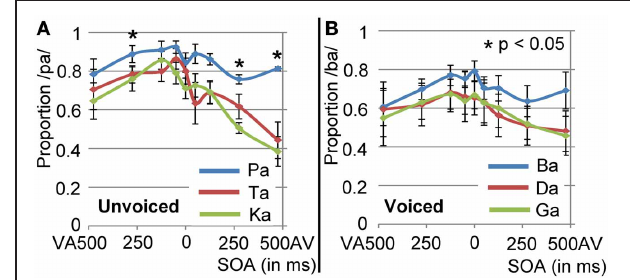
FIGURE 5 | Results for visual /pa/ presentation for unvoiced stimuli (A) and voiced (B) stimuli. Only response proportions are shown for the response options that were given above chance level. These response options were /pa/ and /ba/, for unvoiced and voiced stimuli respectively.